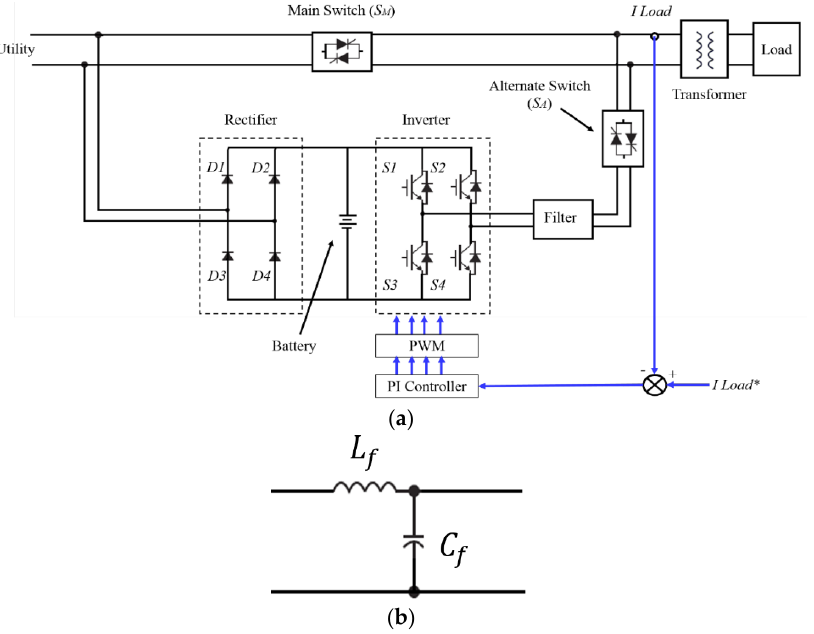
Figure 4. ( a ) Complete diagram of the proposed single-phase UPS system with load transformer; and ( b ) filter circuit.